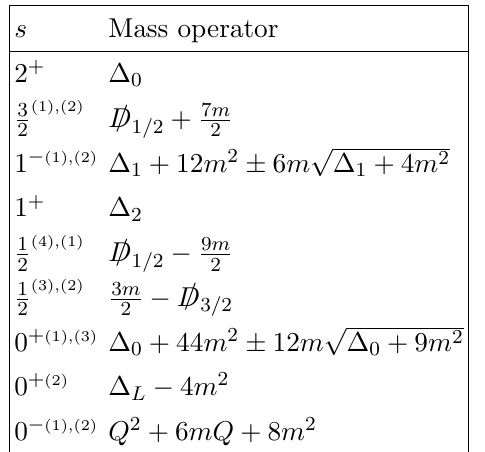
Table 1. E 0 for AdS 4 fields of given mass M and spin s (in SO(3 , 2) irreps D ( E 0 , s )) and the corresponding unitarity bounds.